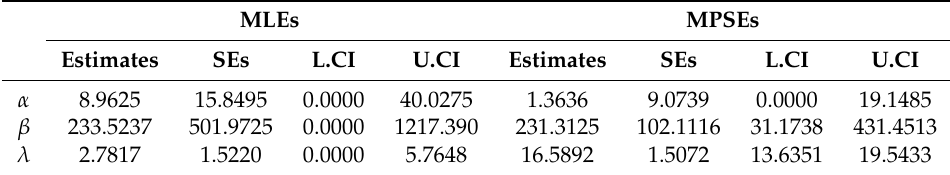
Table 6. Estimates, SEs, L.CI, and U.CI using the MLE and MPS methods under progressive censored electric